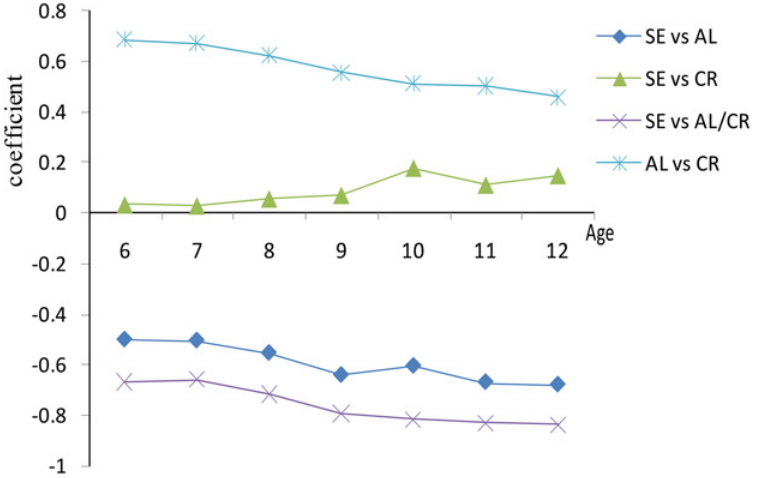
Fig 2. Correlation by age and gender.